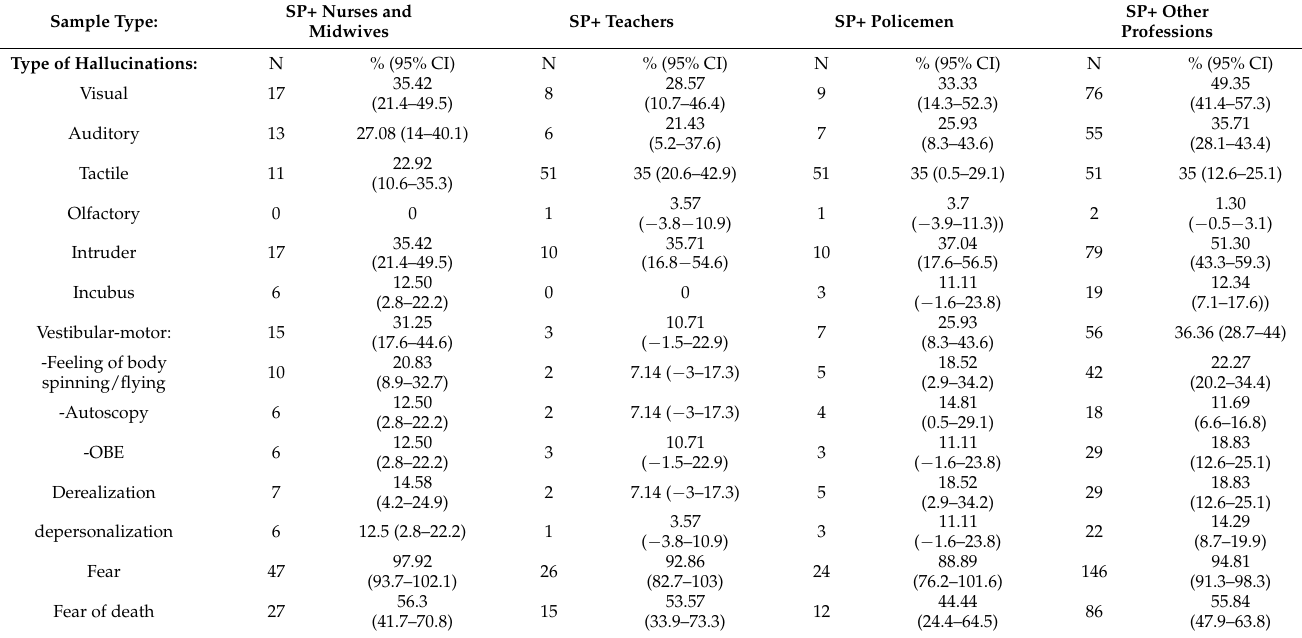
Table 7. The frequency of occurrence of hallucinations during sleep paralysis (SP) in the studied group